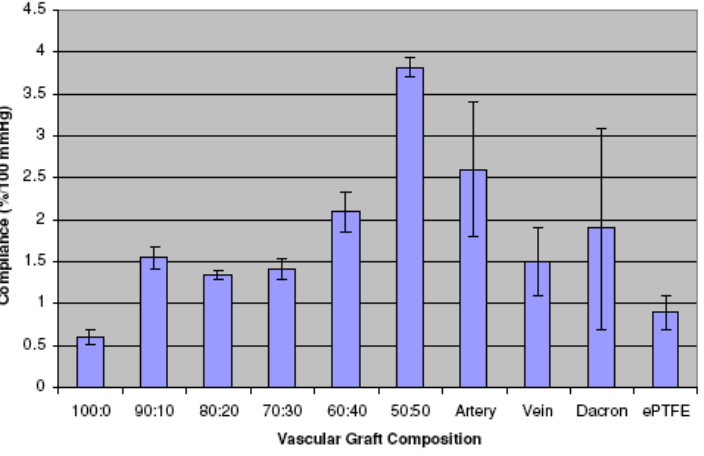
Figure 5. Compliance determined for 120/80 mmHg pressure level for native artery and vein, current synthetic vascular grafts, and electrospun PDO:Elastin blends. Reprinted with permission from IOP Publishing Ltd.